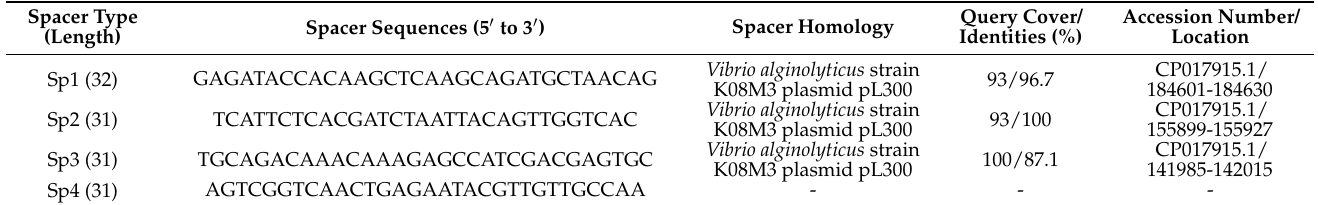
Table 4. Homology analysis of V. parahaemolyticus spacers against foreign genetic elements. Spacer Type (cid:48) to 3 (cid:48) ) (Length) Spacer Sequences (5